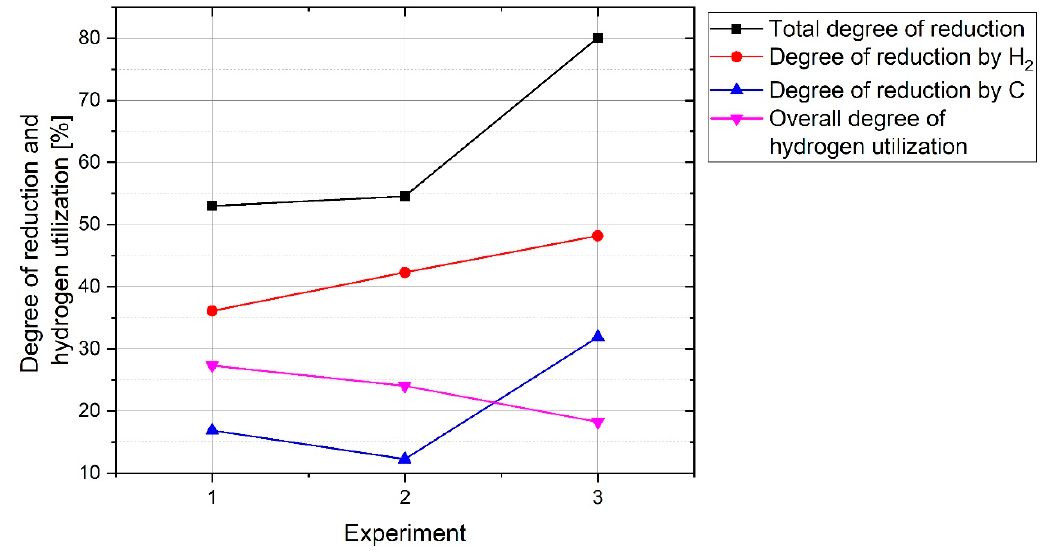
Figure 17. Degree of reduction and hydrogen utilization of Experiments 1, 2 and 3.